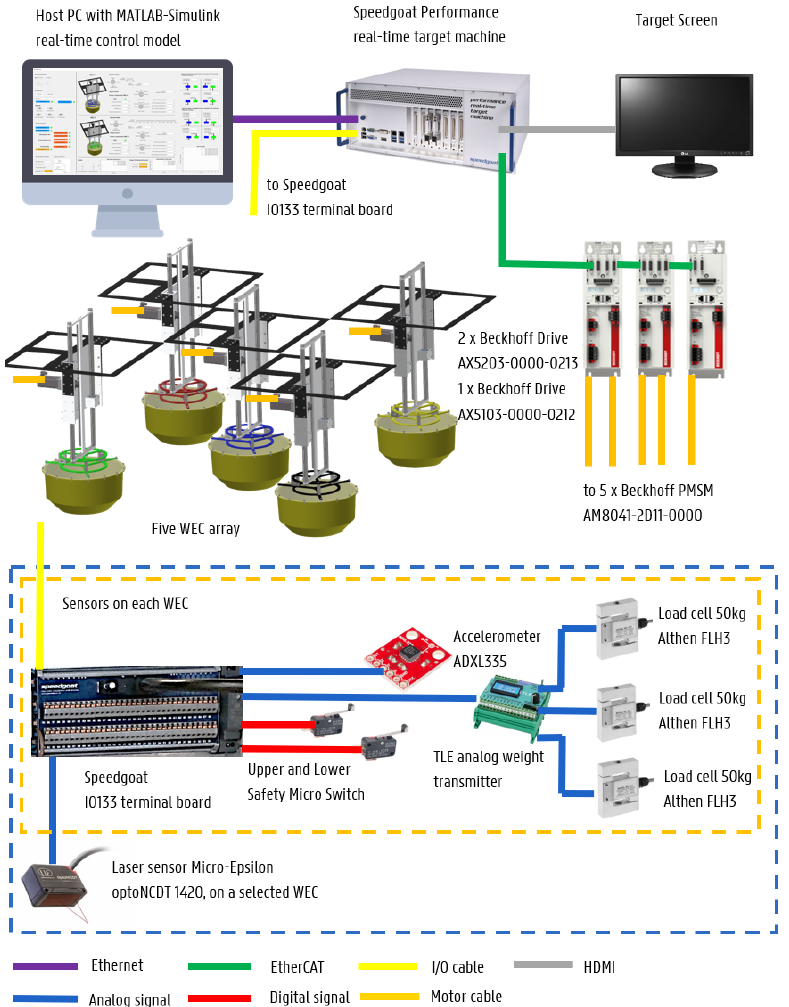
Figure 20. General data acquisition and control flow for the “WECfarm” five-WEC